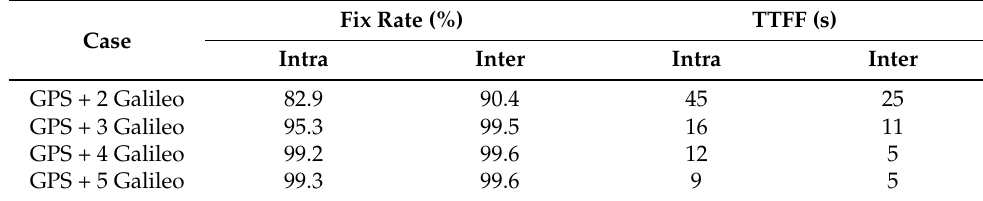
Table 4. Empirical IAR success rates and TTFF for kinematic experiments.